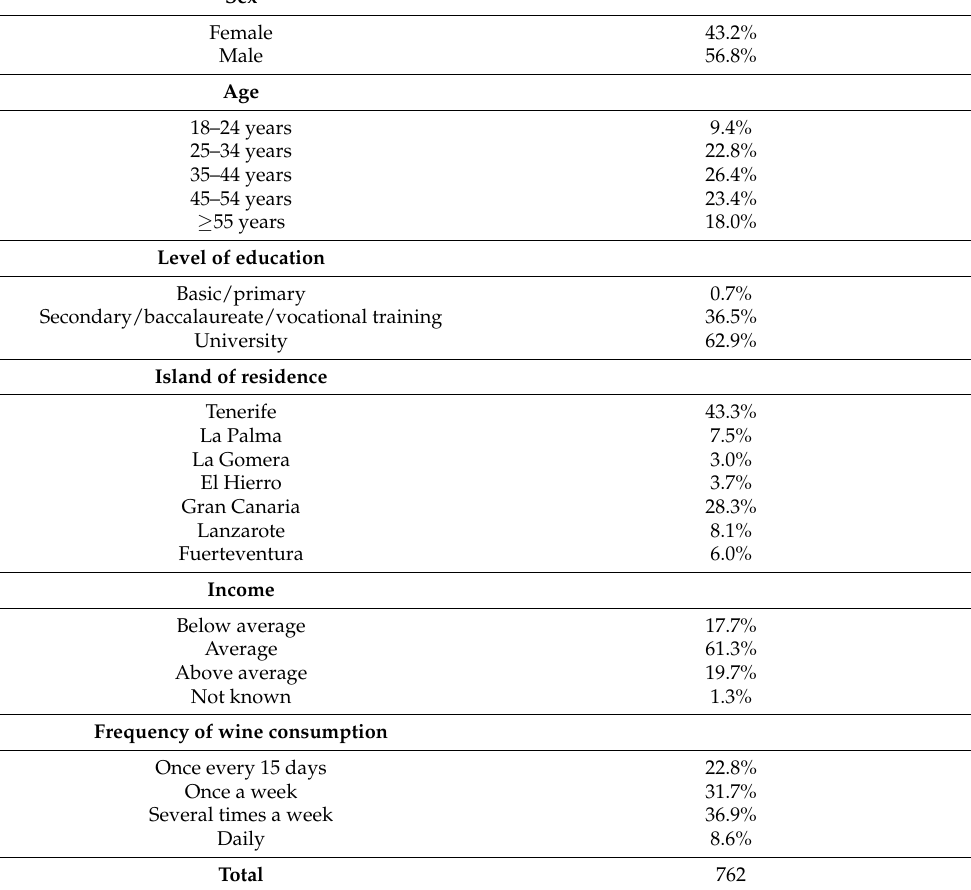
Table 1. Profile of the